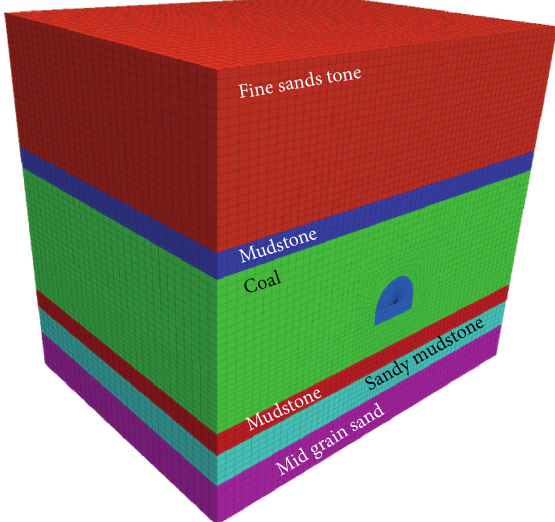
Figure 10: Simulation